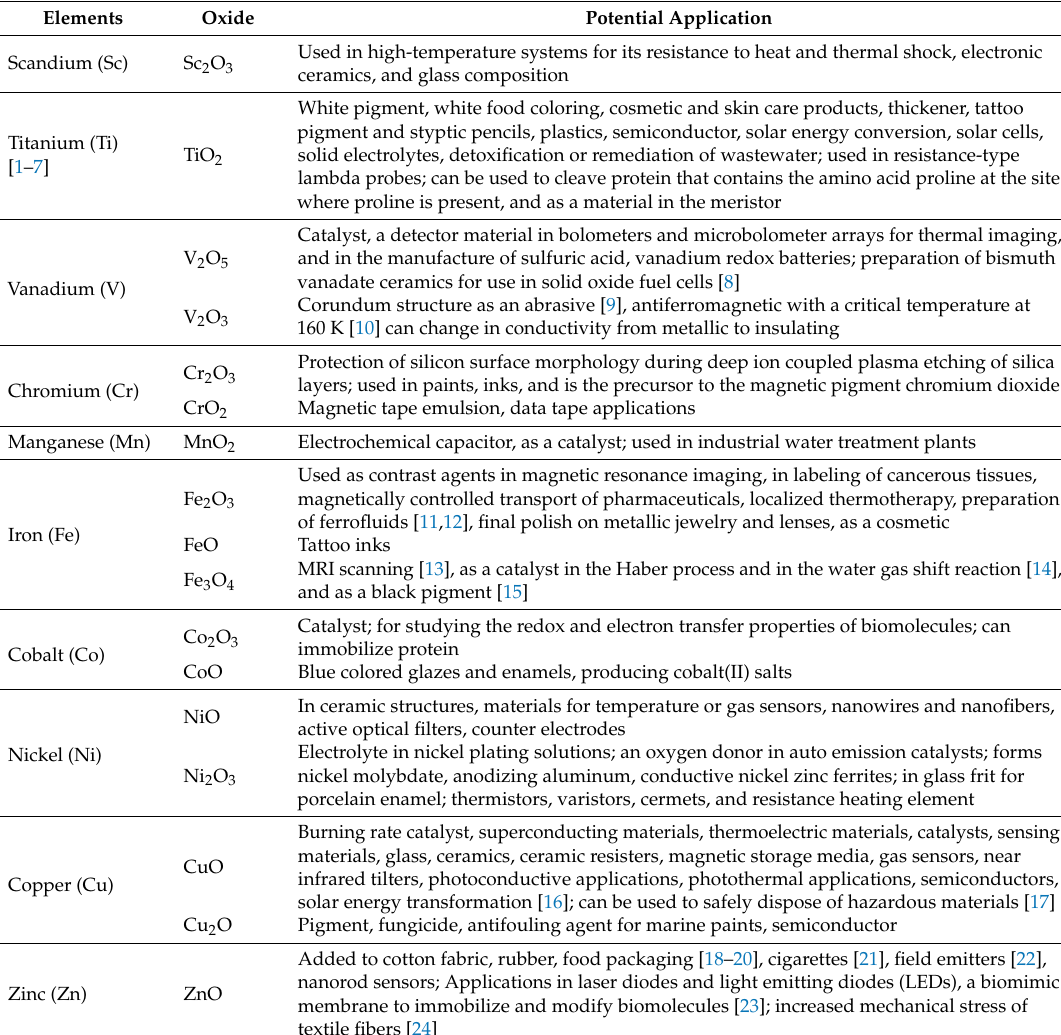
Table 1. Applications of transition metal oxide